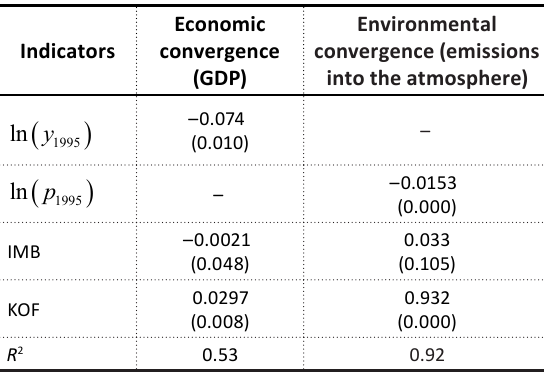
Table 1. The results of macroeconomic instability impact and globalization level on the economic and environmental